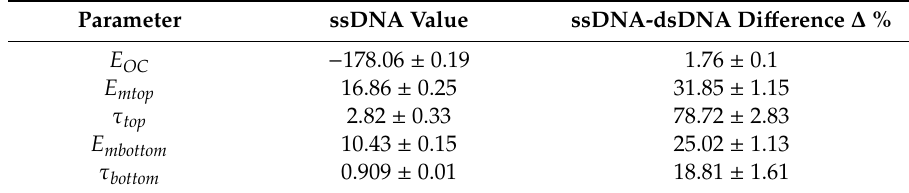
Table 2. Parameters obtained from the fitting for the reverse transient in ssDNA and dsDNA HPV-16.